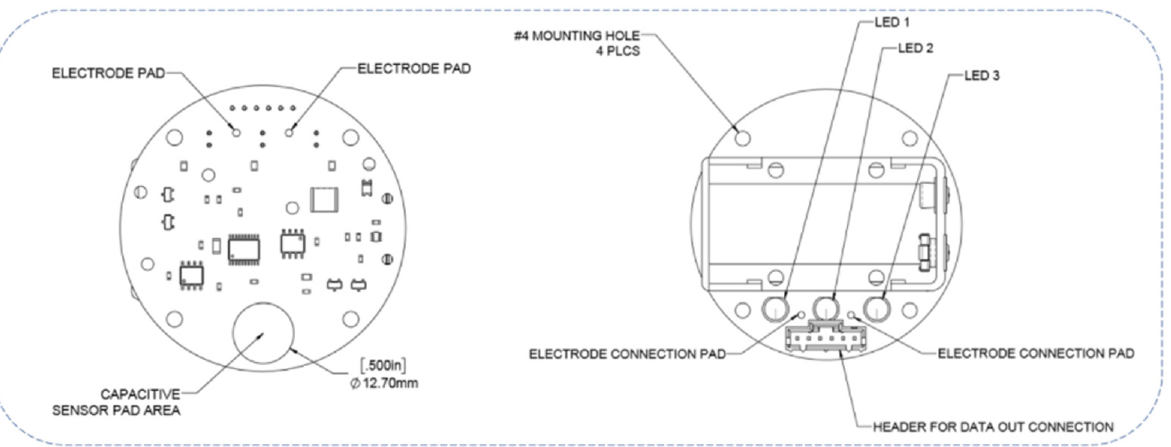
Figure 3. The printed circuit board of the POU device that shows the location of the capacitive touch sensor, the silver wire connection, the three LEDs, and the battery.